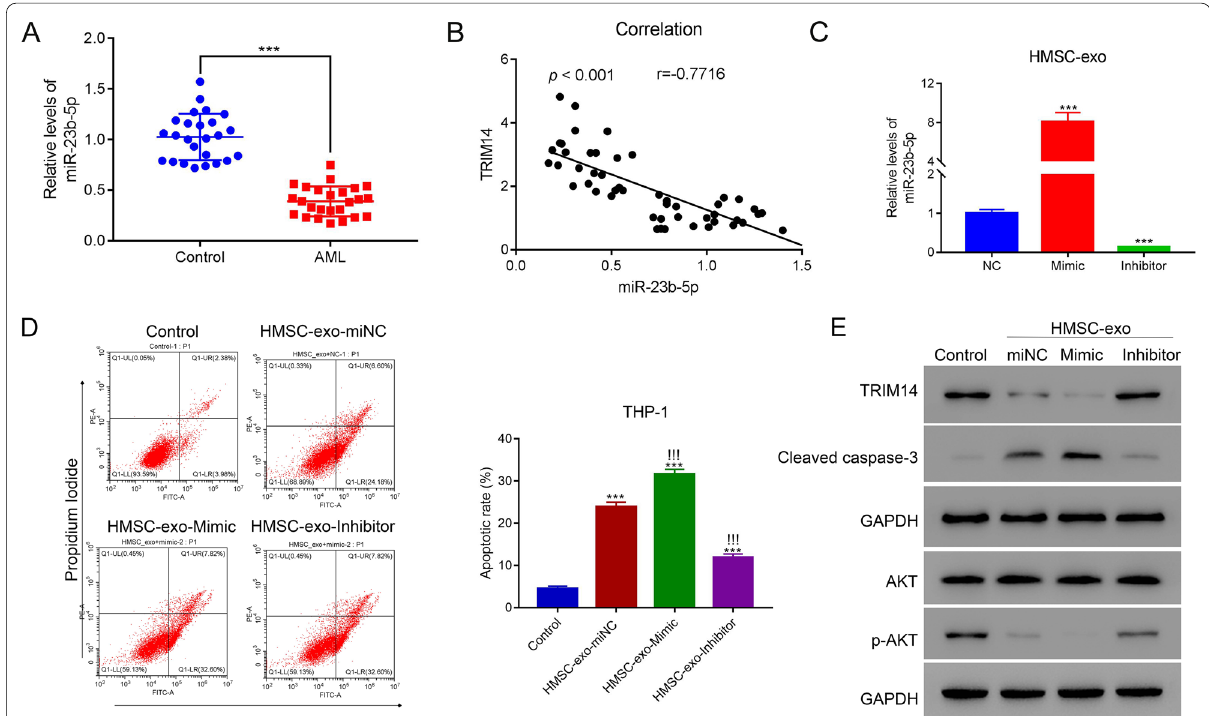
Fig. 4 HMSC-exos induced the apoptosis of AML cells through delivering miR-23b-5p. A The mRNA level of miR-23b-5p of AML patients and healthy donators (n 25 for each group). B The correlation between miR-23b-5p and TRIM14 in AML patients. C The expression of miR-23b-5p in = HMSC-exos after co-cultured with miR-23b-5p mimic or inhibitor. D Flow cytometry detected the apoptosis of THP-1 cells after co-cultured with